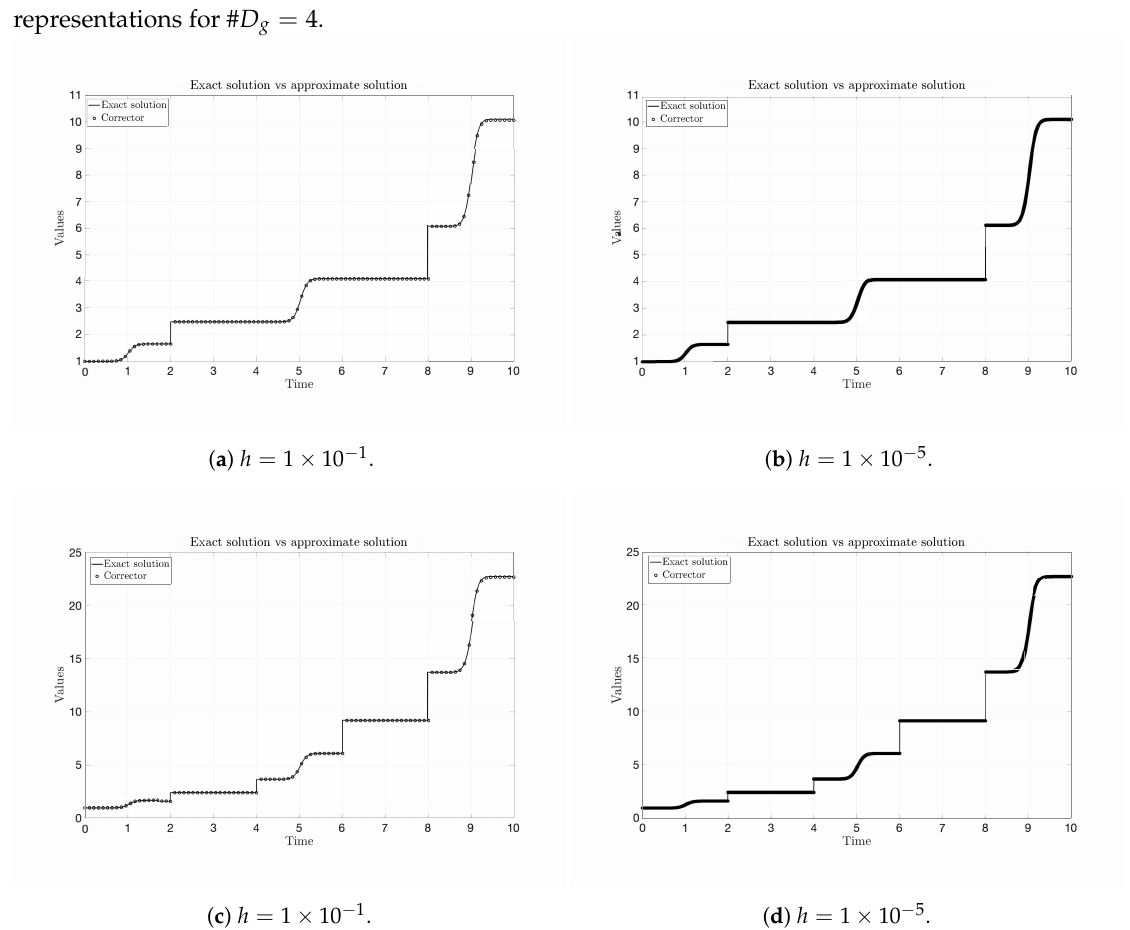
Figure 4. Exact solution (continuous line; vertical lines have to be understood as jumps and not as a multivalued function) vs. approximate solution